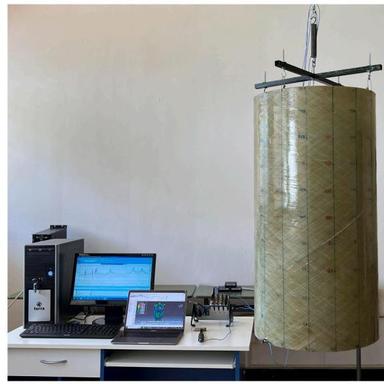
The experimental set-up.